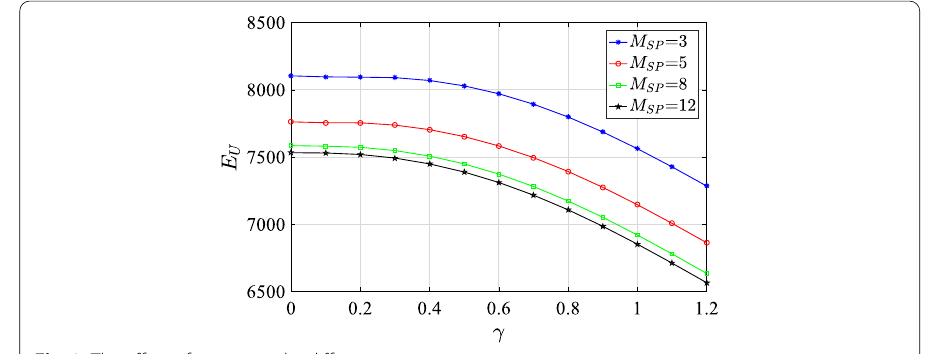
Fig. 3 The effect of γ on E U under different M SP